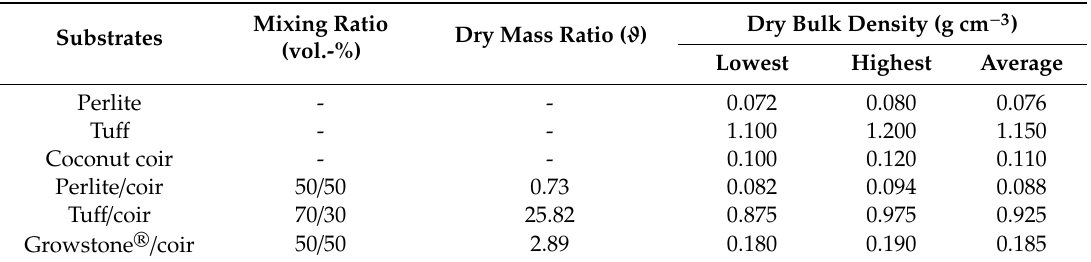
Table 1. Drybulkdensitiesandoven-driedmassratiosofmixturesdeterminedwithcompactionexperiments.